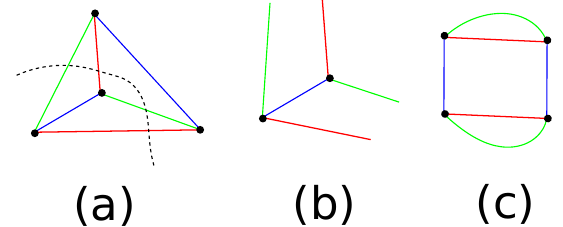
Figure 2: (a) Original CTKT hamiltonian and the cut line. (b) One A b (cid:48) c (cid:48)